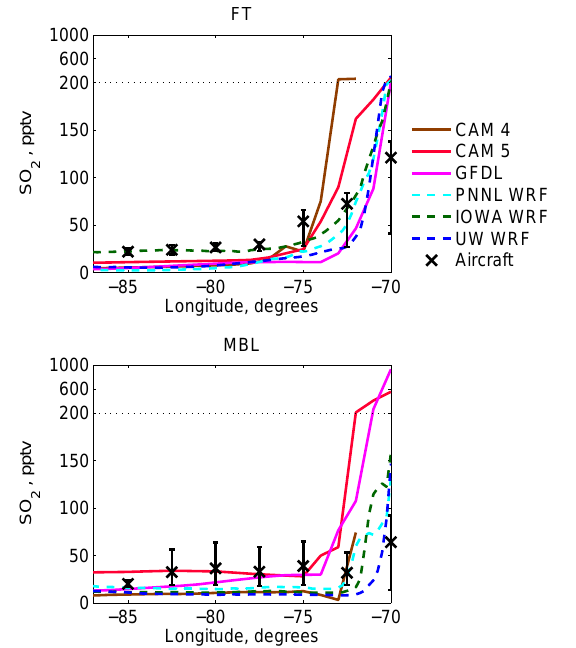
Figure 9. Mean modeled SO 2 (gas) concentration along 20 ◦ S (in pptv) and C-130 aircraft means. The top sections of both panels are rescaled.